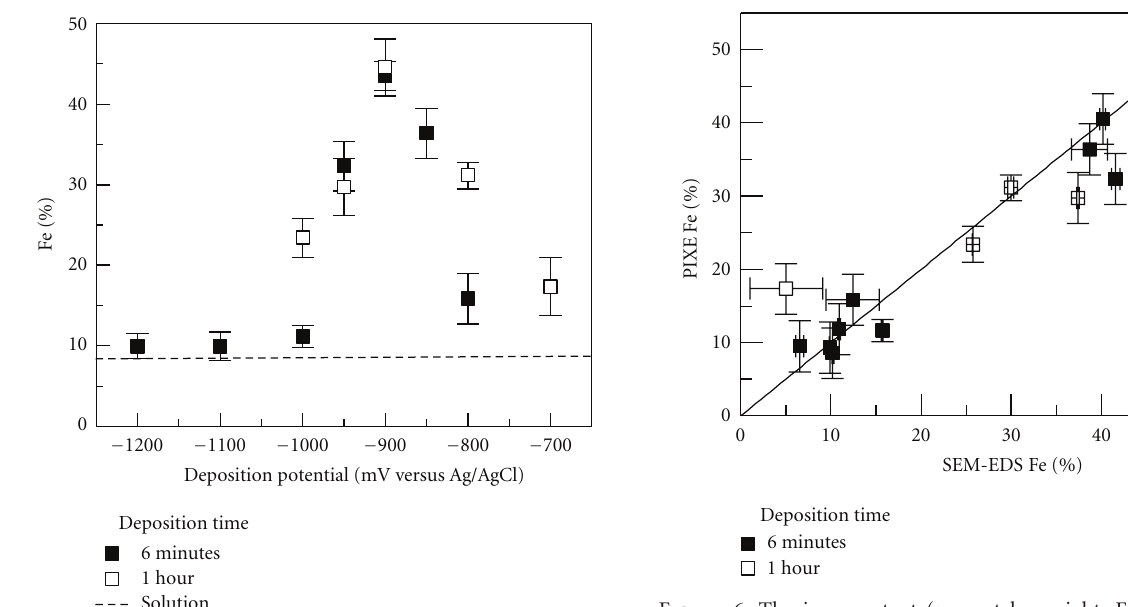
Figure 6: The iron content (percent by weight, Fe/(Ni + Fe) × 100%) in the electrodeposited films determined by PIXE as a func- tion of the iron content (percent by weight) determined by SEM- EDS. The solid line with a slope of unity and an intercept of zero is a guide to the